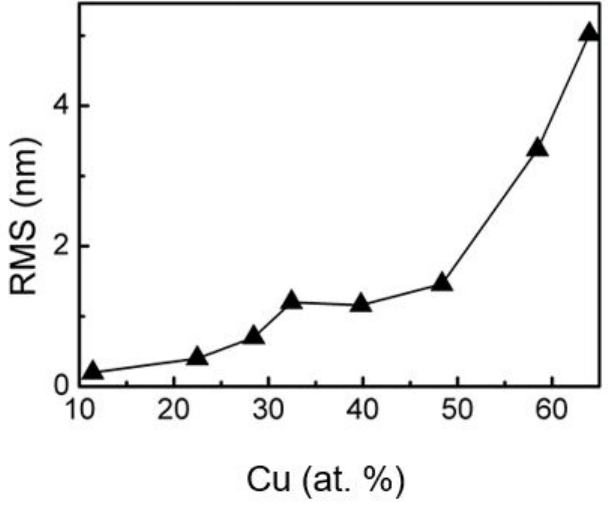
Figure 5. RMS of DLC:Cu films Vs Cu